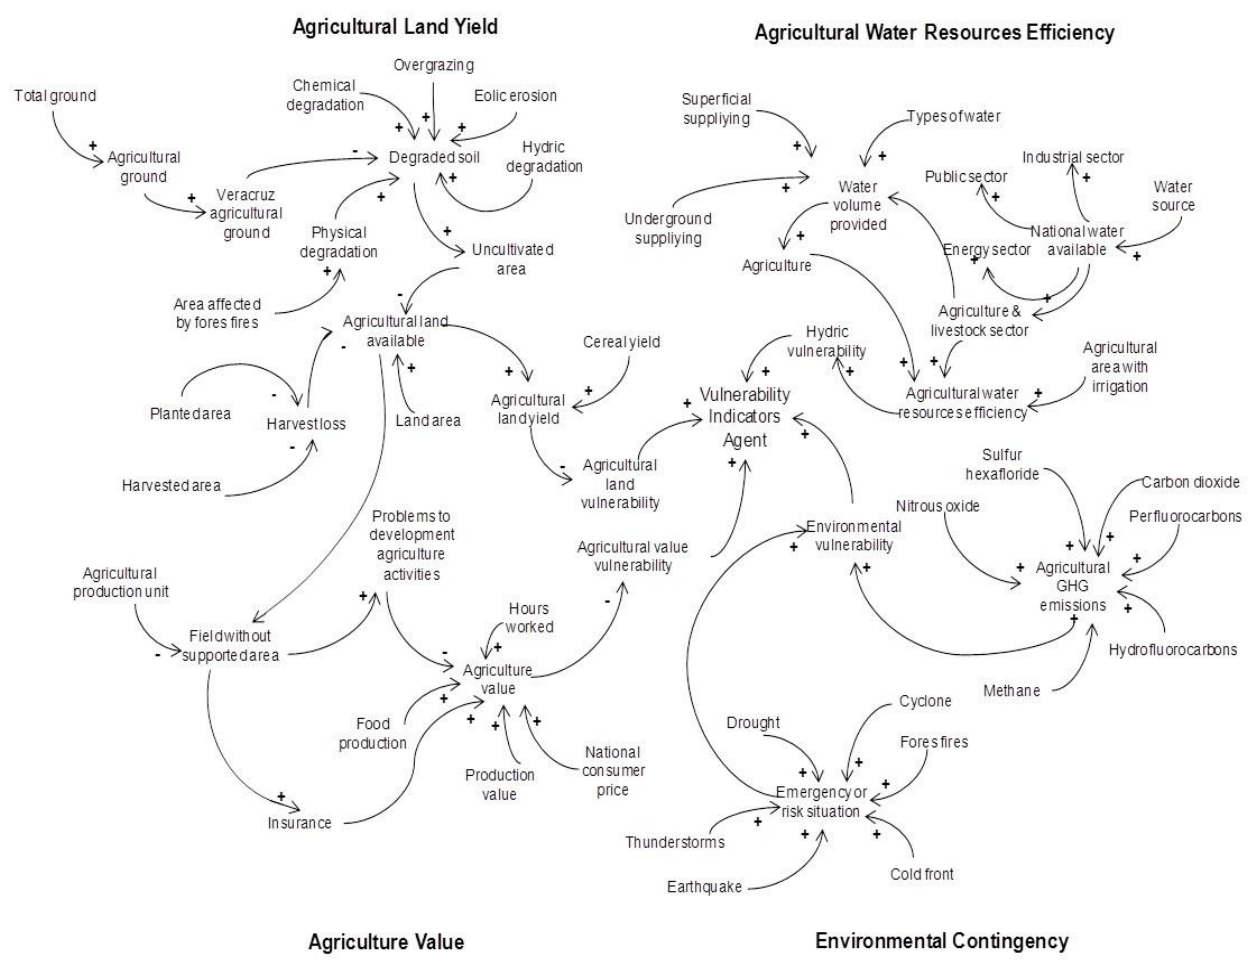
Figure 2. Causal diagram of vulnerability indicators agent model .